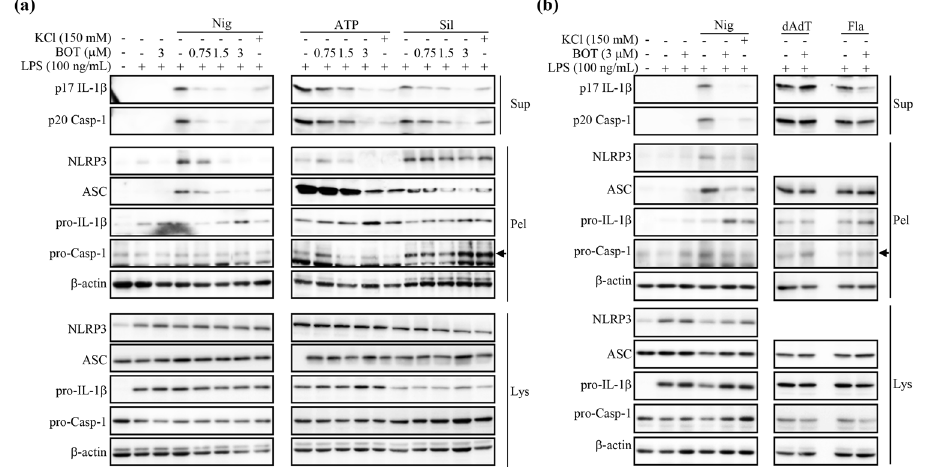
Figure 4. BOT-4-one decreases NLRP3-dependent insolubilization of both NLRP3 and ASC. ( a ) LPS-primed BMDMs were treated with BOT-4-one at different concentrations or KCl for 1 h and then stimulated with nigericin (Nig), ATP, or silica crystals (Sil). ( b ) LPS-primed BMDMs were treated with BOT-4-one or KCl for 1 h and then stimulated with nigericin (Nig), poly(dA:dT) (dAdT), or flagellin (Fla). ( a and b ) The cultured supernatants, soluble lysates (Lys), and insoluble pellets (Pel) of Triton × 100 were analyzed by immunoblot. Full-length blots/gels are presented in Supplementary Fig. S11a and